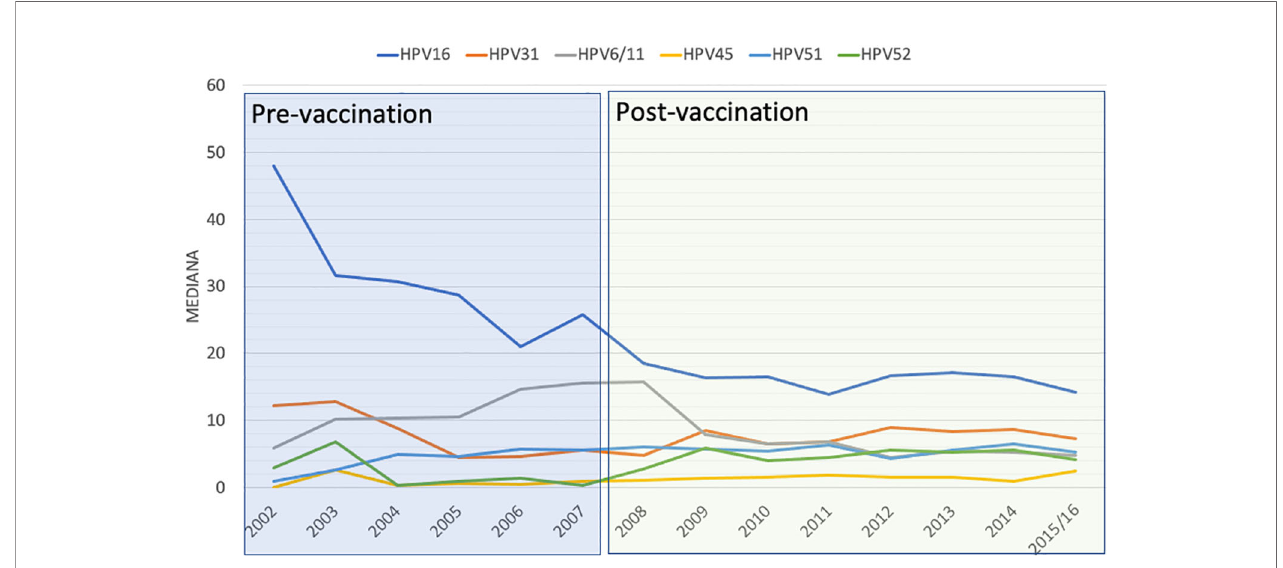
FIGURE 1 | Distribution of the different human papillomavirus (HPV) genotypes along the different years of study.